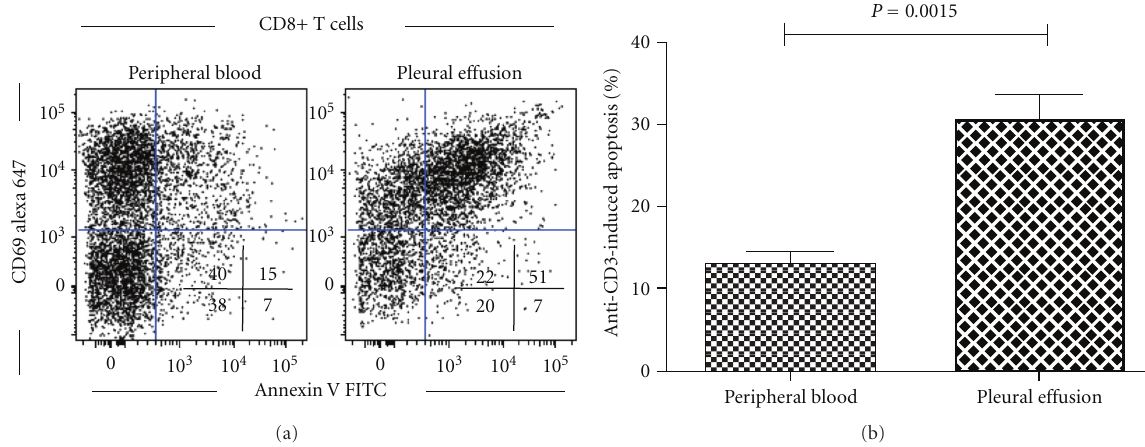
Figure 2: Pleural e ff usion, but not peripheral blood, CD8+ T-cells from lung cancer patients are sensitive to AICD. Both pleural e ff usion and peripheral blood CD8+ T-cells from lung cancer patients ( n = 10) were stimulated with anti-CD3 mAbs for 24h; then apoptosis was determined by annexin V binding in activated CD8+CD69+ T-cells by multiparametric flow cytometry; propidium iodide was used to exclude necrotic cells. (a) Results from a lung cancer patient. (b) Anti-CD3 induced apoptosis was determined as described in [101], comparison was made by paired Student’s t -test. Bars depict the mean ± Standard